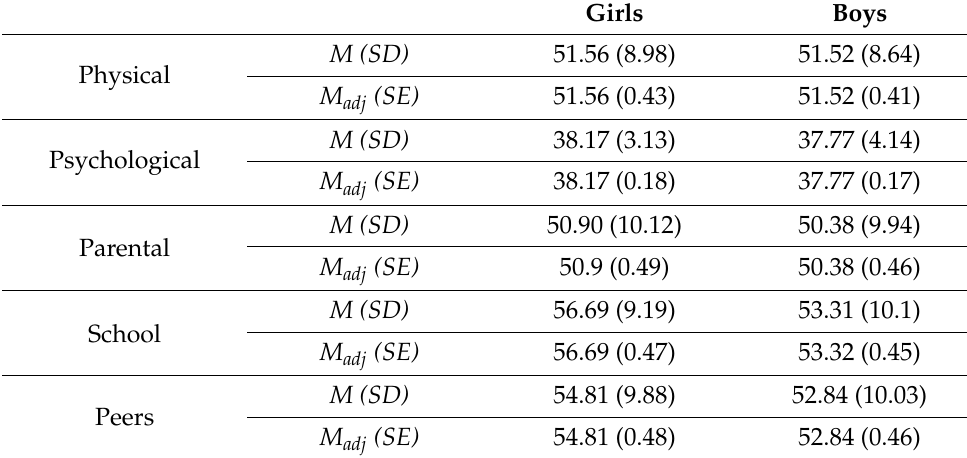
Table 4. Meanandadjustedmeanforthefivewellbeingdimensionsacrossgender. One-wayMANCOVA.